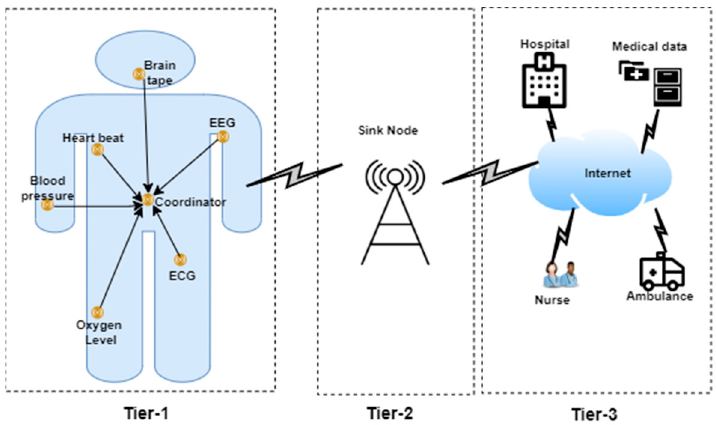
Figure 1. The architecture of wireless body sensor networks